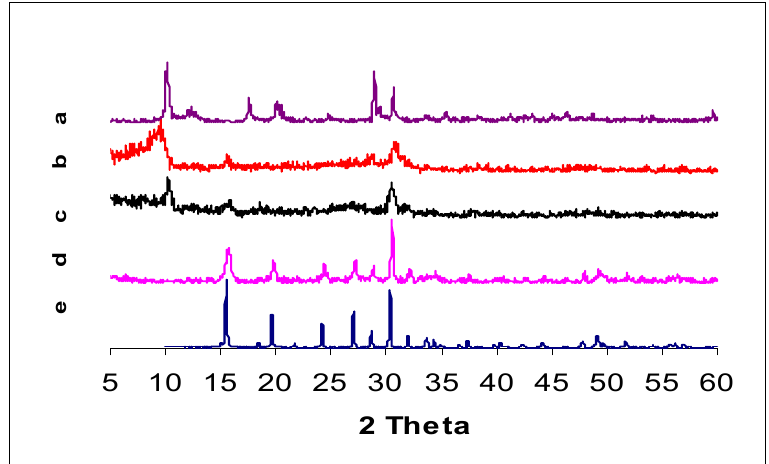
Figure 6. XRD patterns of different VPO materials ( a ) Slurry dried on nitrogen; ( b ) High amount of solvent; ( c ) Medium amount of solvent; ( d ) Low amount of solvent; ( e ) VOHPO ·0.5H 4 2